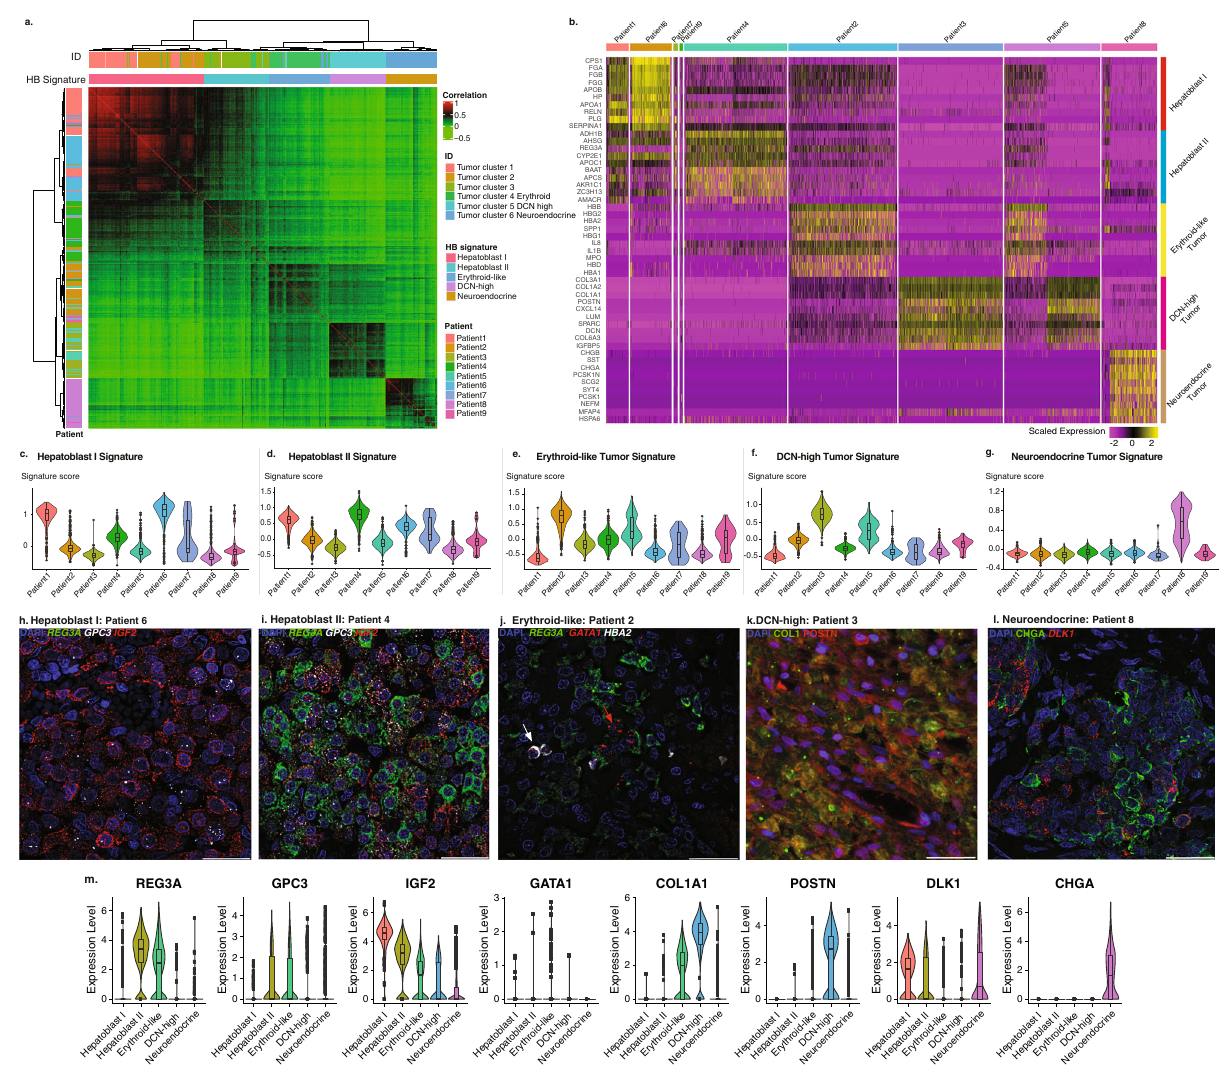
Fig. 2 | Tumor cell analysis reveals fi ve transcriptomically distinct tumor sig- natures detected within the nine HB patients. a Correlation heatmap of the tumor cells by tumor cell clusters, tumor signatures (column annotations), and patients(row annotation).Correlation wasshownby the colorgradient.Hierarchal clusters were illustrated by dendrograms. b Heatmap of top 10 most differentially expressed genes of each HB signature. Scaled expressed levels are shown by the color bar. c Violin and box plot of the computed c.Hepatoblast I, d Hepatoblast II, e Erythroid-like, f DCN-high, and g Neuroendocrine tumor signature scores for all nine patients ( N =6244 cells). h FISHstaining for REG3A (green), GPC3 (white),and IGF2 (red) of patient 6 tumor tissue (Hepatoblast I), and i patient 4 tumor tissue (HepatoblastII). j FISHstainingfor REG3A (green), HBA2 (white),and GATA1 (red),of